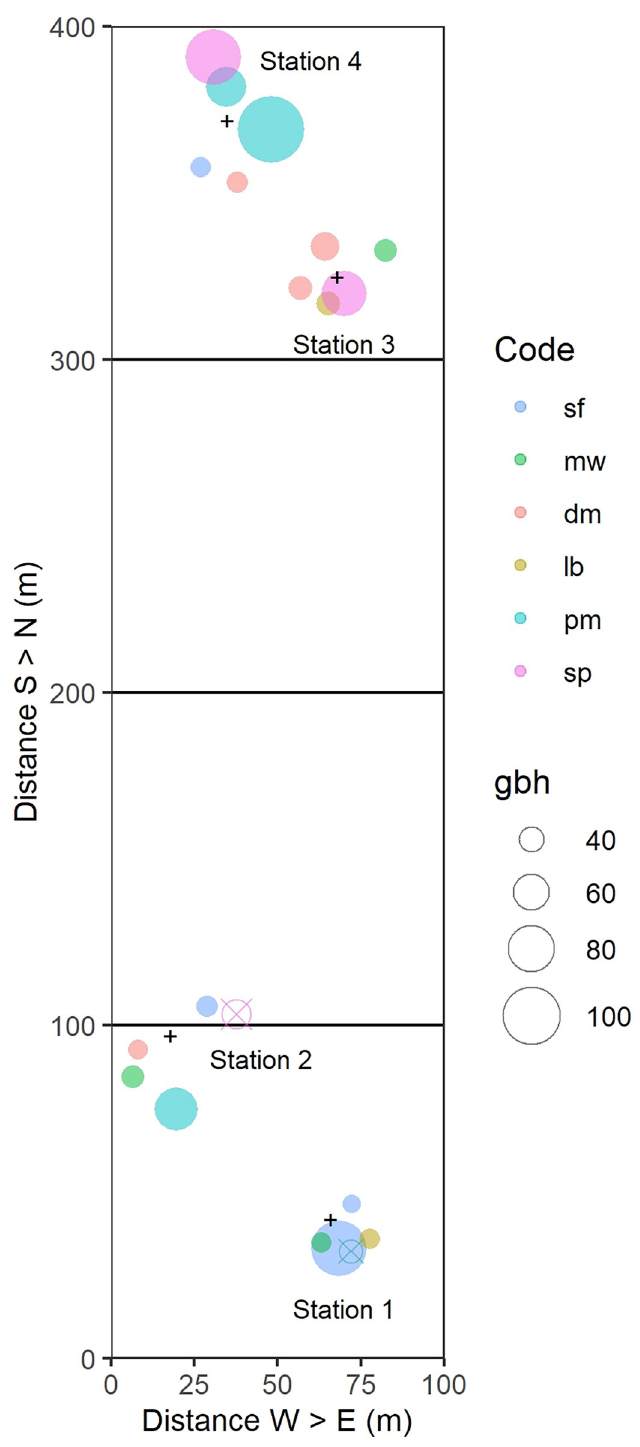
Fig 1. Positions of the banded trees at the four stations in main plot 2 at Danum. The small plus signs indicate the positions of the loggers. Closed colored symbols, scaled to tree stem girth ( gbh , in cm), show the species of tree (Table 1): codes for them are listed in Table 2. The open crossed symbols indicate the two trees (g13, g21) that were omitted from the analyses.